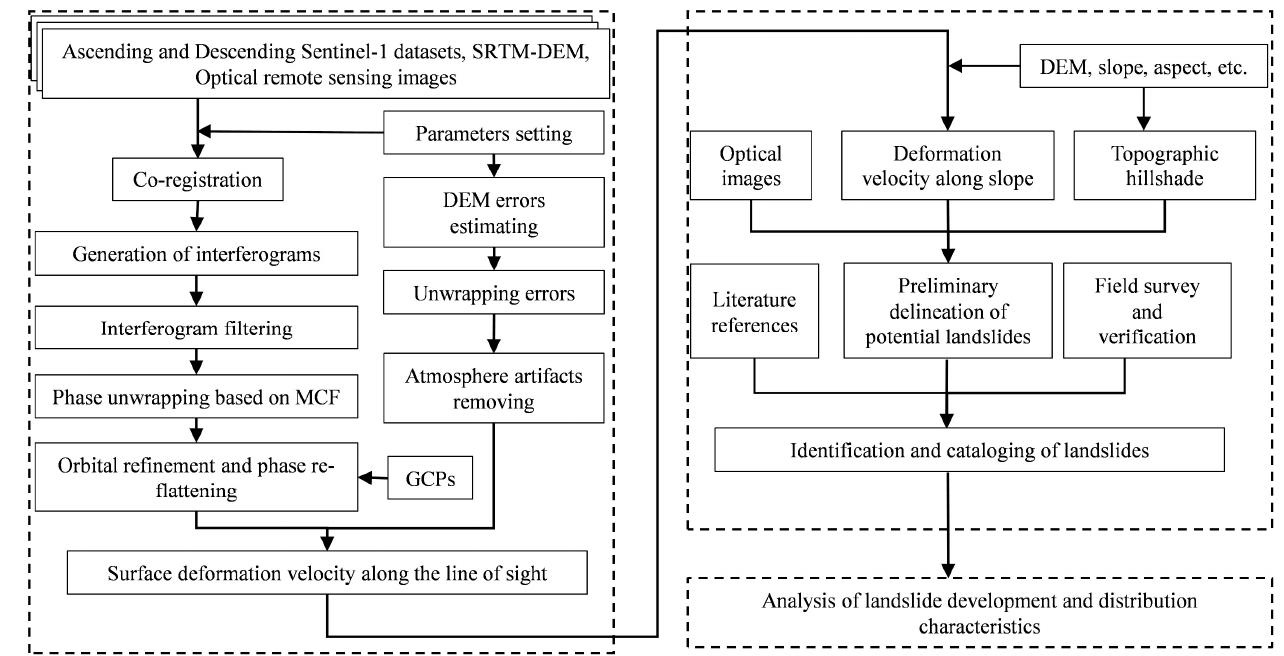
Figure 3. Flowchart for deformation monitoring, landslide detection, and analysis.